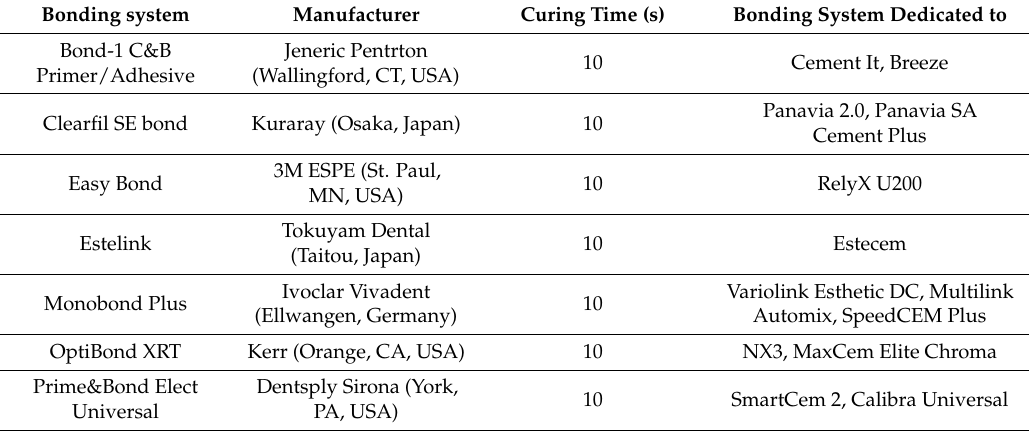
Table 2. The curing time of bonding